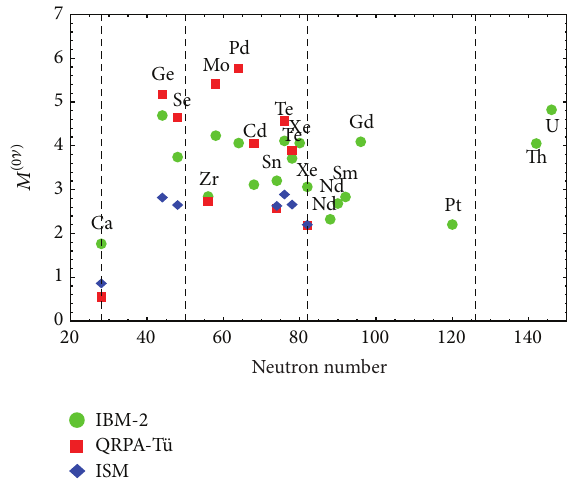
Figure 10: Most updated NMEs calculations for the 0 ] 𝛽𝛽 with the IBM-2 [96], QRPA-T¨u [163], and ISM [164] models. The results somehow differ among the models but are not too far away. Figure from